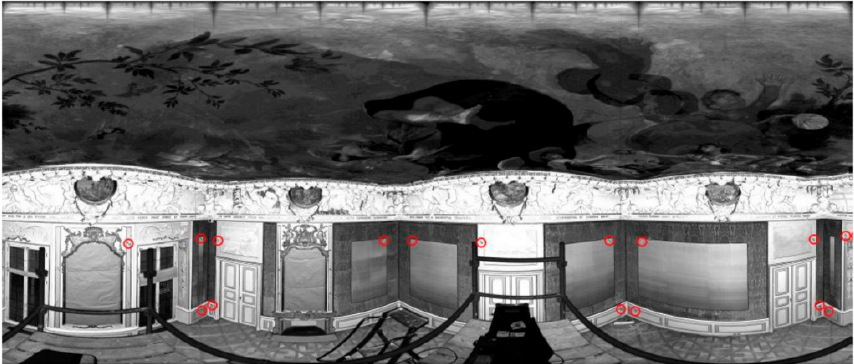
Figure 1. The point cloud in the Mercator projection of Test Site I: “The Queen’s Bedroom” with marked check points (red circles) [27].